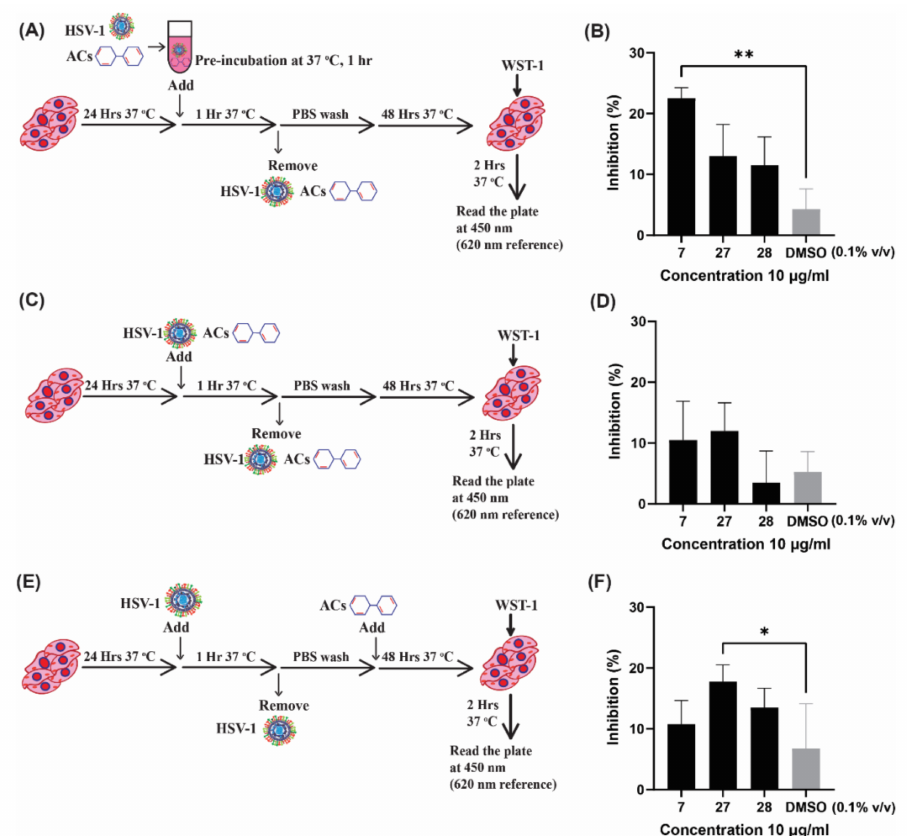
Figure 4. Antiviral screening assays for three selected active compounds. The antiviral activity of active compounds (ACs) was investigated at three different stages. The antiviral activity of ACs #7, #27, and #28 was tested at 10 µ g/mL. ( A ) Schematic diagram of the viral inactivation assay performed by preincubating Herpes Simplex Virus type 1 (HSV-1) with ACs for 1 h prior to addition to cells is. ( B ) Results of the viral inactivation assay. Viral attachment and entry inhibition of ACs were investigated by simultaneously adding the virus and ACs to cells, as shown in ( C ); results are shown in ( D ). The post-entry antiviral effect of ACs was tested by adding ACs after infection ( E ); results are plotted in ( F ). Cells infected with the virus and treated with dimethyl sulfoxide (DMSO) at 0.1% v / v were included as solvent controls. This experiment was performed four times with triplicates. Means of the four experiments are plotted with standard error of the mean. Friedman test,